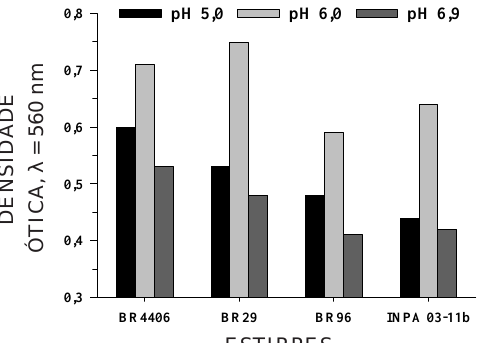
Figura 3. Densidade ótica de estirpes de Bradyrhizobium em 10 8,8 UFC mL -1 , considerando o pH de